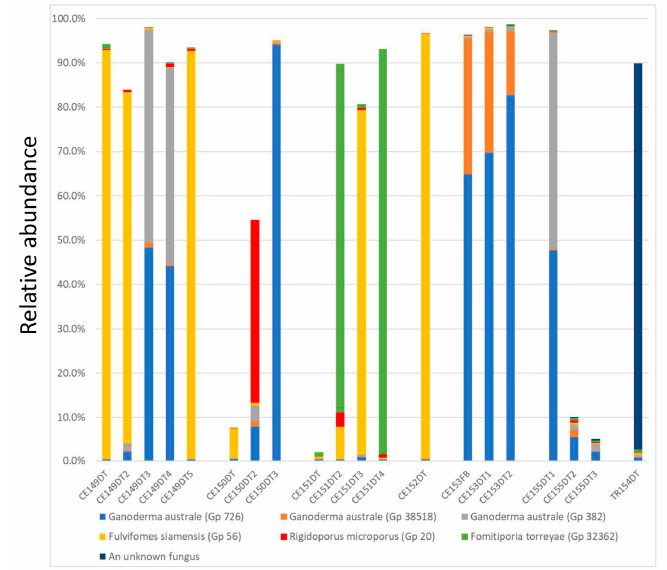
Figure 6. Fungi genetic heterogeneity in Casuarina’s diseased tissues. All the seven trees were located near each other at the West Coast Park, Singapore. A fruiting body and multiple decayed wood samples were subjected to a metagenomic analysis, and the relative abundances of selected OTUs are presented in the bar chart (as percentages of the total sequence reads for the sample). GenBank